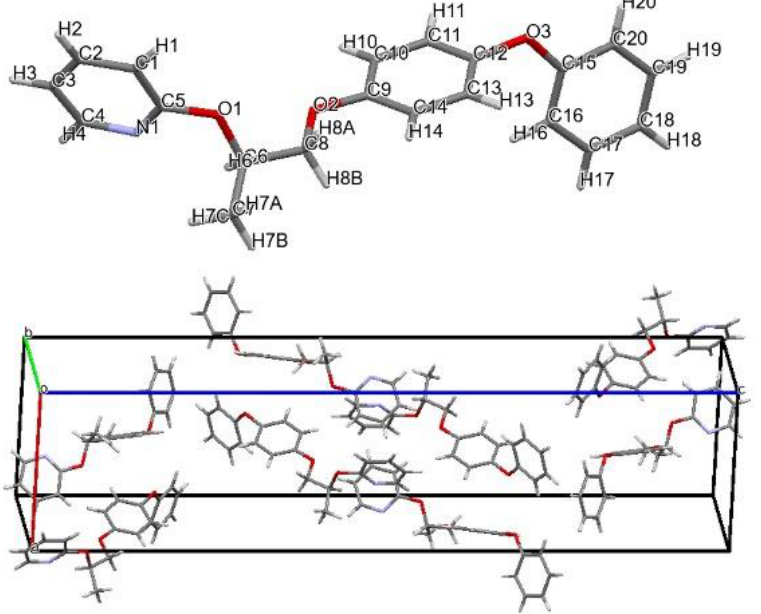
Figure 1. Molecular structure and lattice structure of pyriproxyfen. The crystal structure of pyriproxyfen was taken from CSD [26].